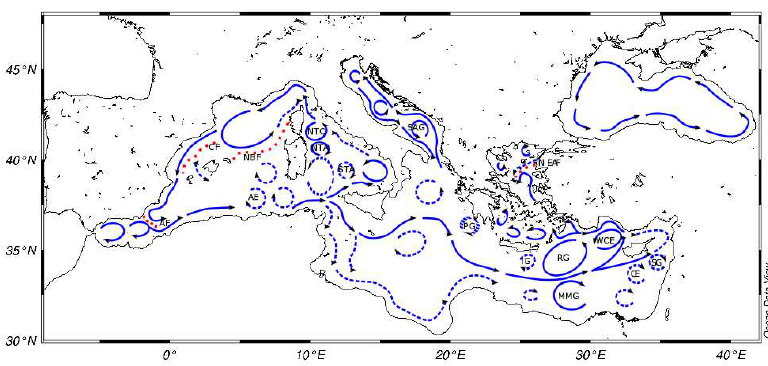
Fig. 2. Key traits of surface circulation of Mediterranean Sea. Acronyms: AE: Algerian Eddies; AF: Almerian Front; CE: Cyprus Eddy; WCE: West Cyprus Eddy; CF: Catalan Front; IG: Ierapetra Gyre; MMG: Mersa Matruh Gyre; NBF: North Balearic Front; NEAF: North East Aegean Front; NTA: North Tyrrhenian Anticyclon; NTC: North Tyrrhenian Cyclon; PG: Pelops Gyre; RG: Rhodos Gyre; SAG: South Adriatic Gyre; SG: Shikmona Gyre (sources: Artegiani et al., 1997; Malanotte-Rizzoli et al., 1997; Millot, 1999; Astraldi et al., 2002; Karageorgis et al., 2008; Rinaldi et al., 2009).